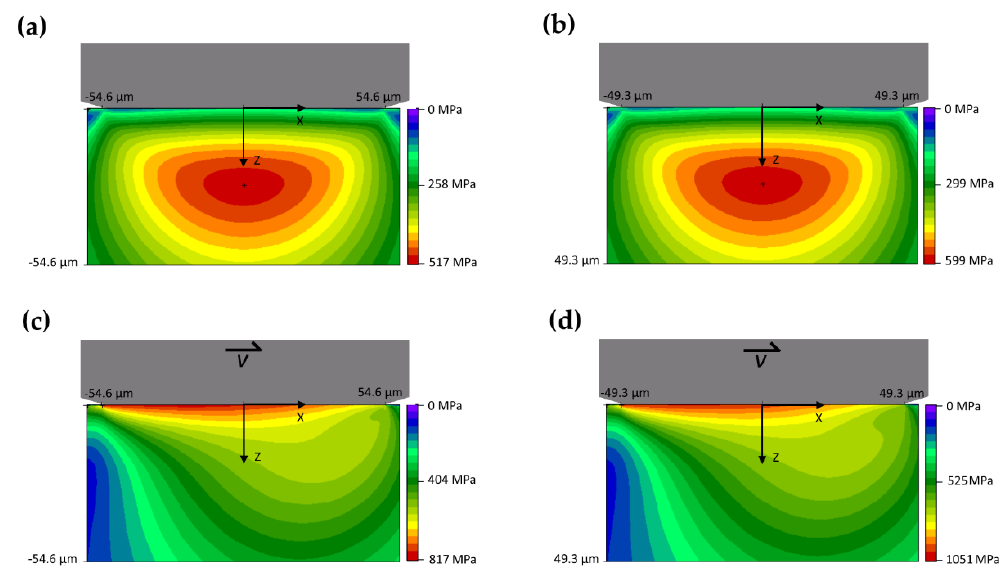
Figure 7. Two-dimensional Von Mises stress for the pin/disc non-conformal contact. ( a , c ) represent the WC – 6Co/Ti20 – AlSi contact in static ( a ) and dynamic ( c ) conditions, while ( b , d ) represent the WC – 6Co/Ti80 – AlSi contact in static ( b ) and dynamic ( d ) conditions.